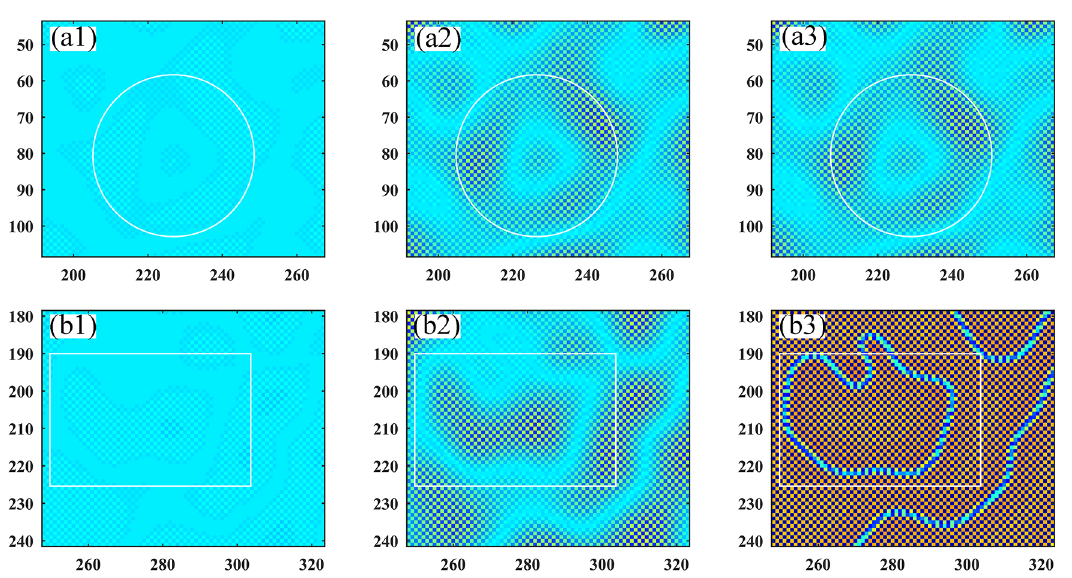
Figure 3. Micrographs displaying the formation process of closed APDB. (a1-a3) t = 50, 950, 1000, respectively; (b1-b3) t = 50, 950, 1000, respectively.